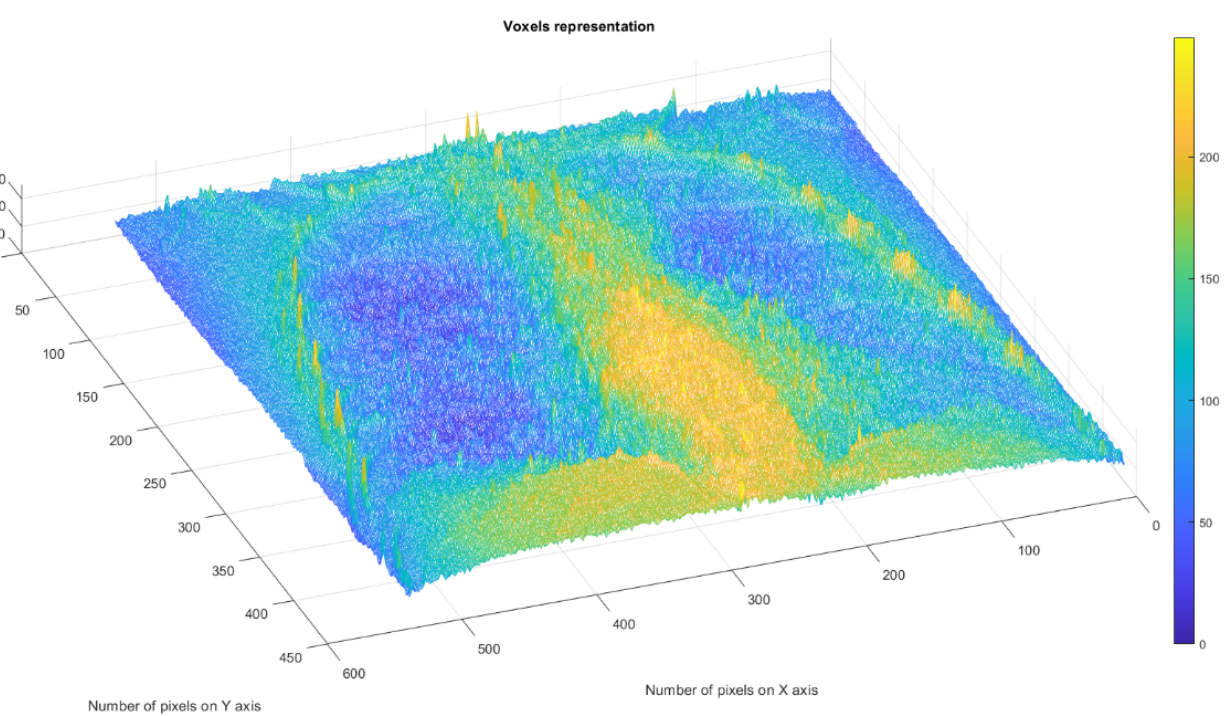
Figure 5. De fi ning the mask for the right lung of the fi rst patient.